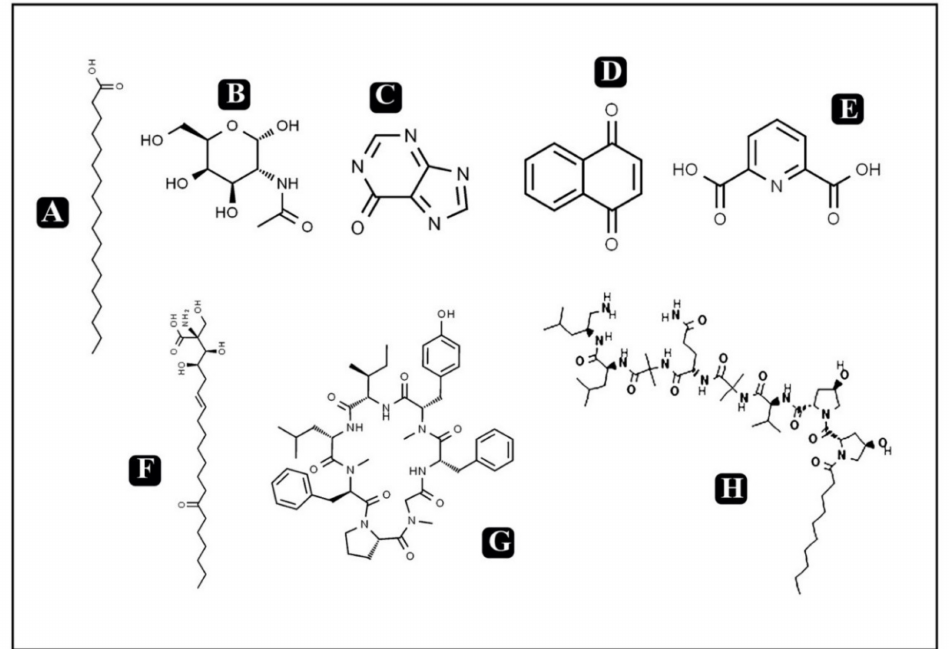
Figure 2. Chemical structures of some known and potent bioactive compounds in Cordyceps. ( A ) Stearic acid ( B ) N -acetyl muramic acid ( C ) Hypoxanthine ( D ) Nephthaquinone ( E ) Dipliconic acid ( F ) Myriocin ( G ) Cordyheptapeptide A ( H ) Cicadapeptin 1.